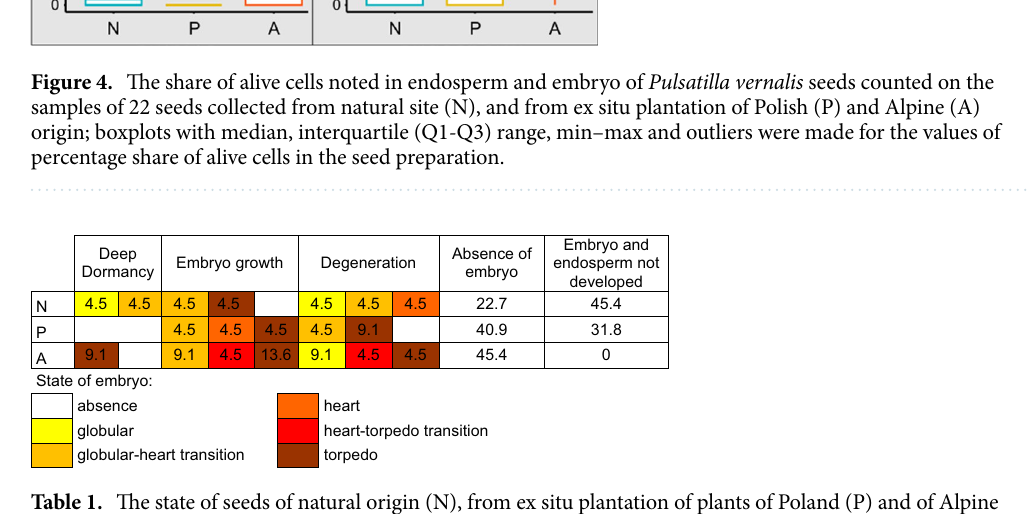
Table 1. The state of seeds of natural origin (N), from ex situ plantation of plants of Poland (P) and of Alpine origin (A); the numbers represent percentages of seeds with embryos at the particular stage; alive seeds at ‘deep dormancy’ stage mean the embryo and endosperm with > 95% of alive cells; ‘embryo growth’ means the seeds with alive embryos and partly dying endosperm; seeds during ‘degeneration’ means those with more than 5% of dying embryo